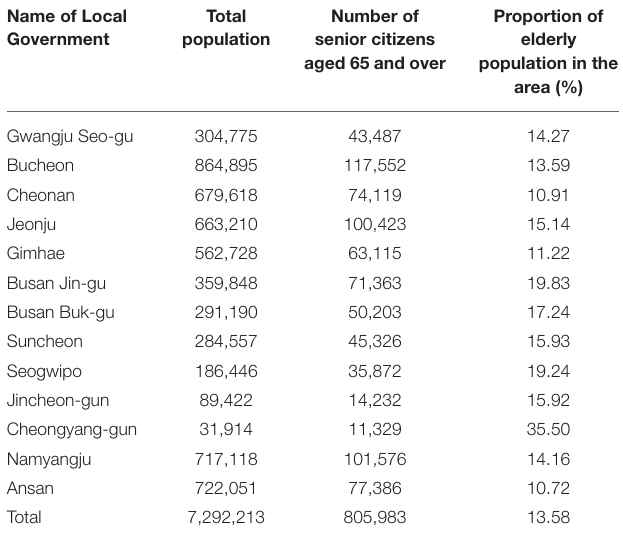
TABLE 1 | Characteristics of the composition of the local population in the operation of integrated care for the elderly in the local community. Name of Local